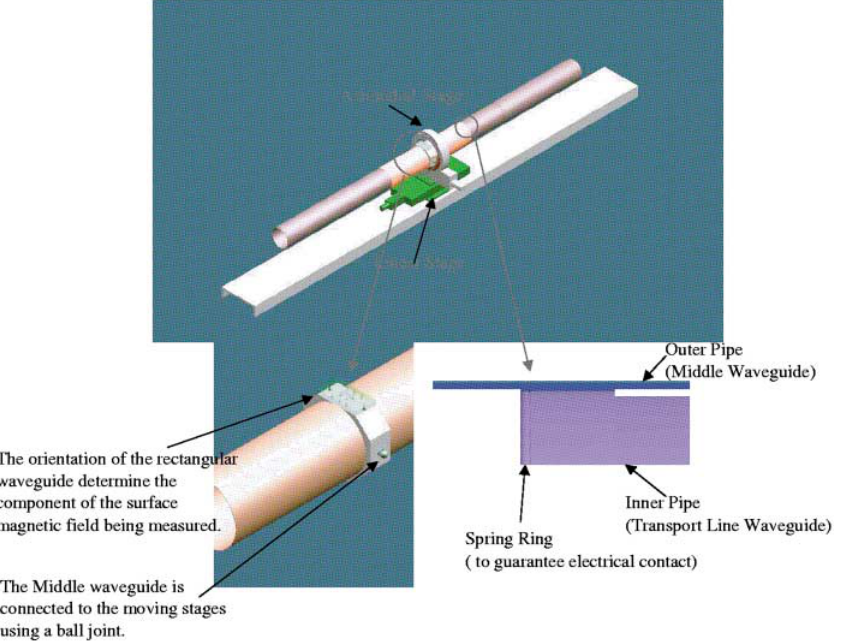
FIG. 2. (Color) The mode